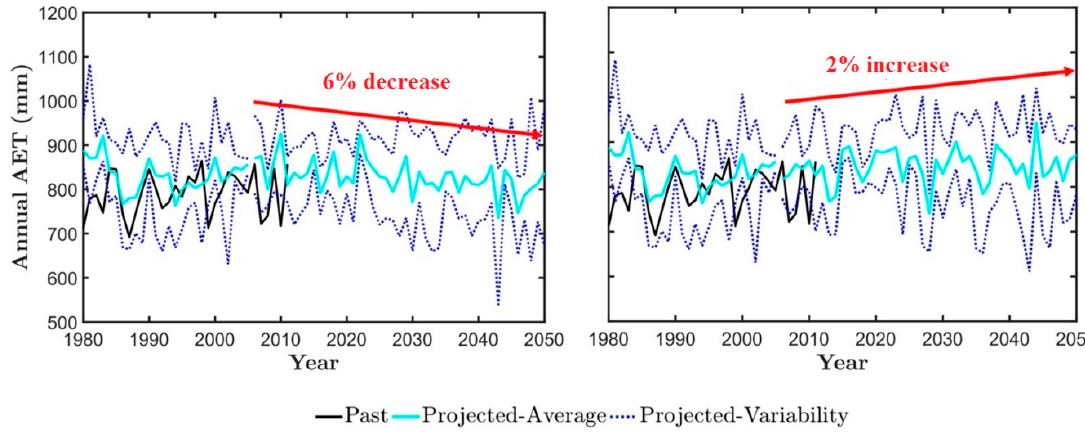
Figure 11. Time series of annual AET based on four GCM models for the historical period (1980–2005) and projected period (2006–2050) considering RCP 4.5 ( left ) and RCP 8.5 ( right ). The average curve is the average of four GCM models, and the variability curves are the minimum and maximum of four models. The red line is the slope of the time series during the projected period. The percent change from 2006 to 2050 is shown in red above each line.